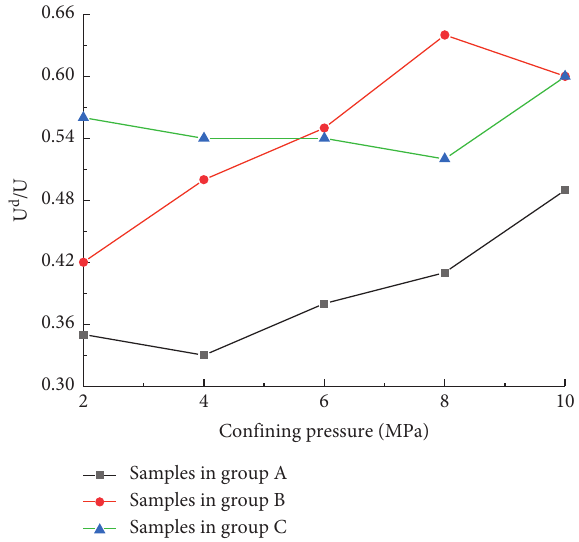
Figure 7: Curve of the samples U d /U changing with confining pressure at the peak stress